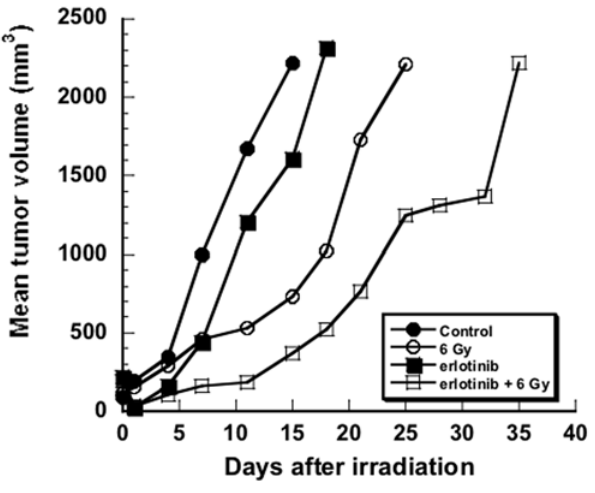
Figure 6. Effect of erlotinib on invivo and invitro radiation response. Mice were implanted with SQ20B xenografts. When tumors reached a size of , 1 cm in diameter, half the mice were started on erlotinib feed; half were not. After 4 days of this feed, half the erlotinib– treated and half the control mice received 6 Gy; half of each group received no radiation. Mean values for tumor size are plotted on the graph.